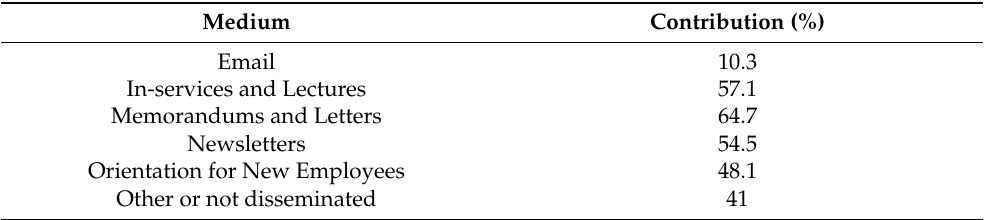
Table 4. The dissemination of medication errors [62]. Reprinted with permission from Ref. [62]. 2009 Wiley Online